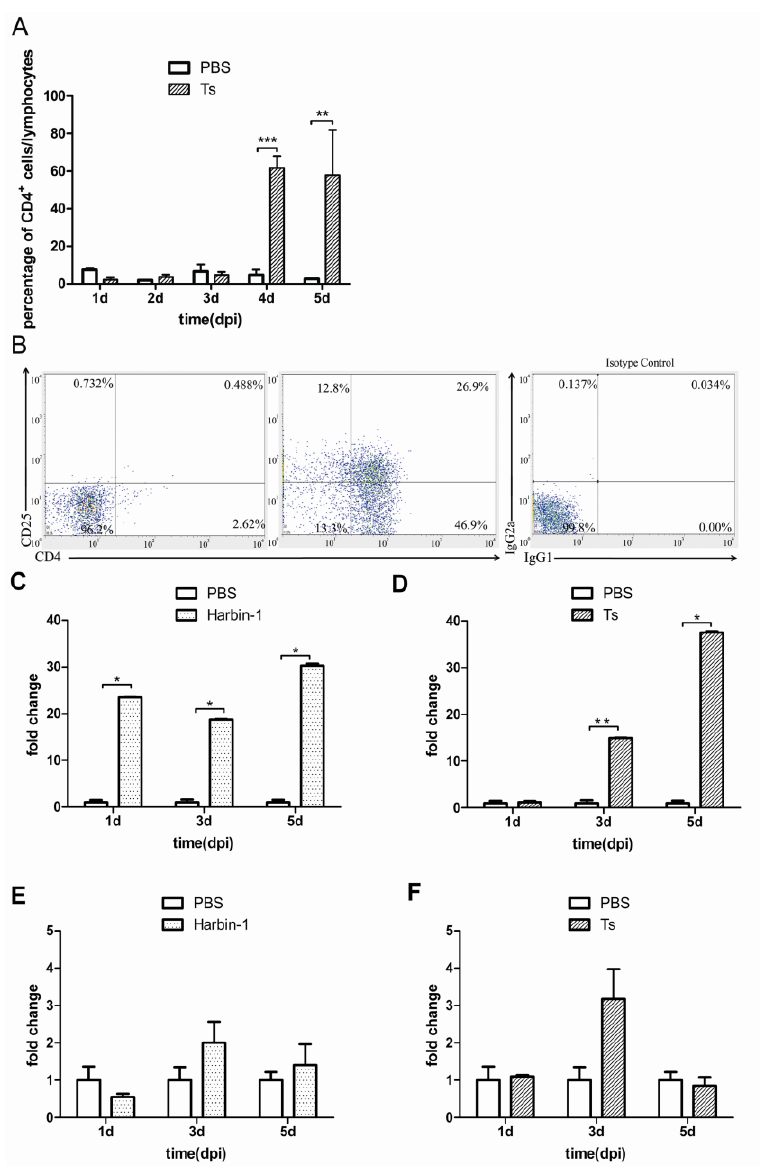
Figure 5. Changes in lymphocytes in the bursa of Fabricius from Ts-infected chickens and cytokines expression levels in IBDV-infected bursal tissues. ( A ) Changes in CD4+ cells in the bursa of Fabricius of SPF chickens infected with the Ts strain; ( B ) Ratio of CD4+CD25+ cells among the CD4+ cells in the bursa of Fabricius of SPF chickens infected with the Ts strain. Left: PBS control; middle: Ts-infected (4 dpi); right: isotype control; ( C , D ) Changes in IL-10 expression in the bursa of Fabricius of SPF chickens infected with the Harbin-1 or Ts strain; ( E , F ) Changes of TGF- β expression in bursa of Fabricius of SPF chickens infected with the Harbin-1 or Ts strain. Note: the y-axis in Figure 5A indicates the ratio of CD4+ cells/lymphocytes; the y-axis in Figure 5C–F indicates the fold change of the IBDV group/PBS group, and the x-axis means the time after Harbin-1 or Ts strain-infected SPF chickens. Data represent mean ±SEM from 3–5 individuals. * P ≤ 0.05; ** P ≤